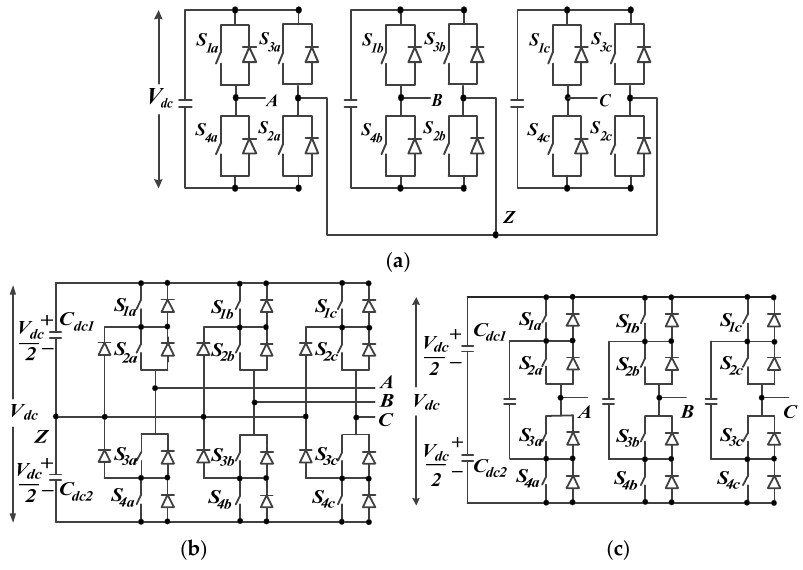
Figure 15. Typical circuit topologies of three-phase three-level inverter; ( a ) CHB ( b ) NPC and ( c ) FC [18].